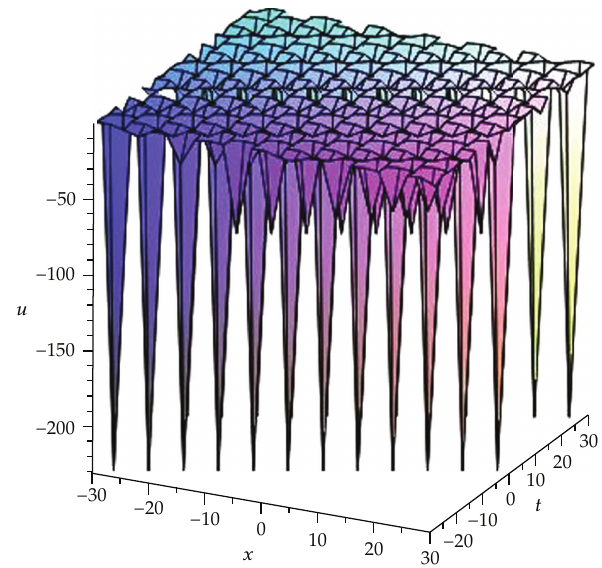
Figure 9: The solution u 11 of GSWW equation with k (cid:7) 0 . 1, c (cid:7) 2, α (cid:7) 3, β (cid:7) 1.